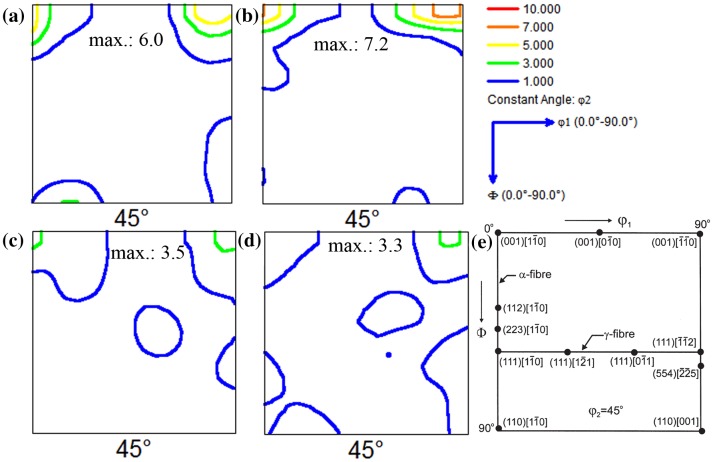

ϕ
2 = 45° ODF sections. (a) Annealed SG sample; (b) Annealed LG sample; (c) SG sample, ε: 8.1%; (d) LG sample, ε: 8.8%. (e) Drawing of the most relevant texture orientations in bcc metals located in the ϕ
2 = 45° ODF section.